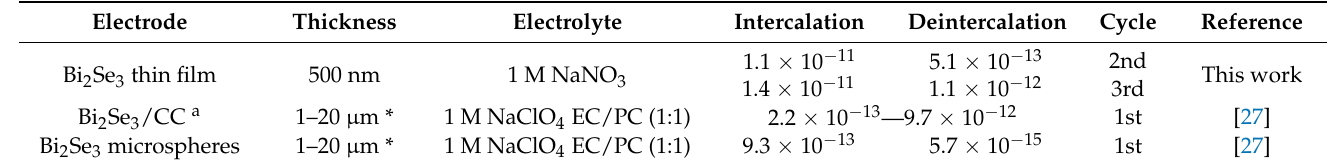
Table 3. Na + intercalation–deintercalation diffusion coefficient (cm 2 s − 1 ) comparison with other